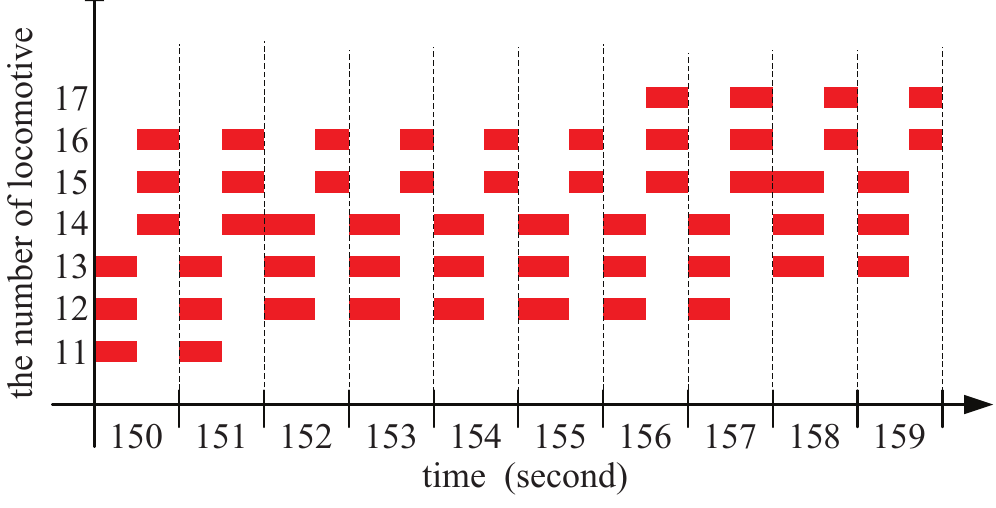
Figure 6. The time slots division from second 150 to second 159